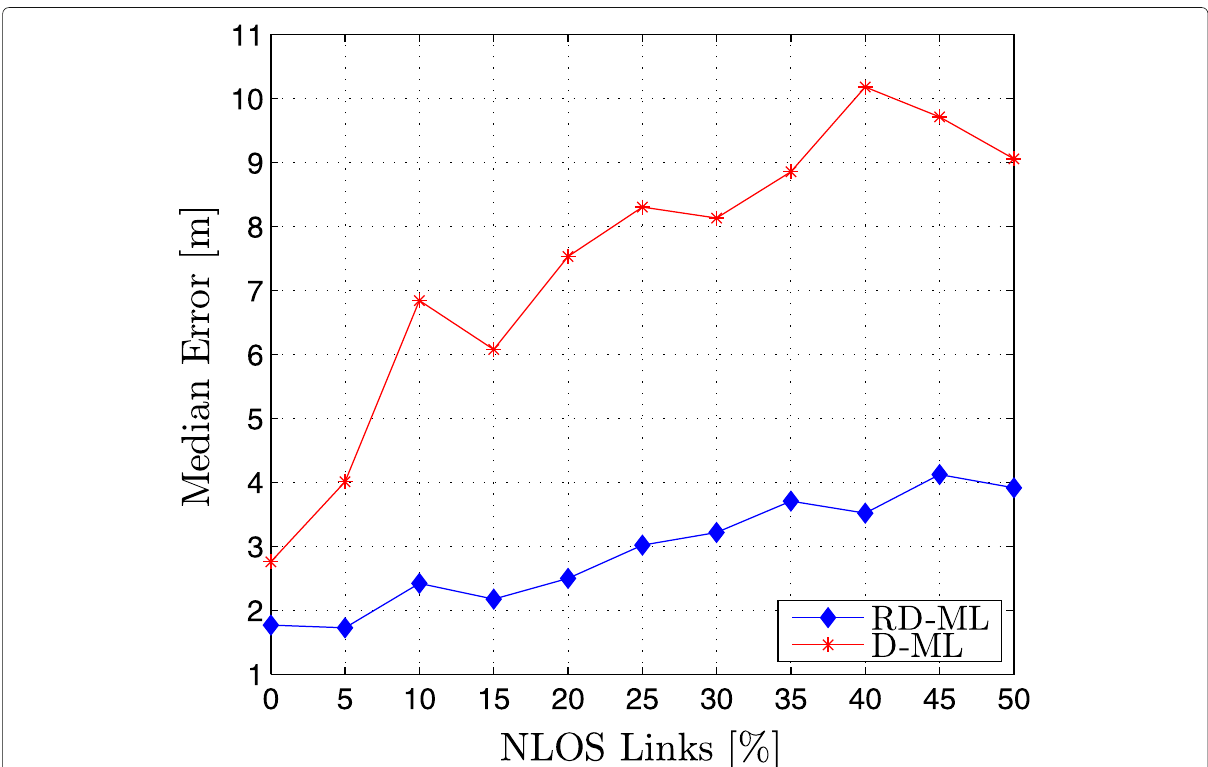
Fig. 11 Median error of RDML and D-ML for a variable fraction of NLoS links. Fully connected networks, K = 40, N a = 11, N u = 10